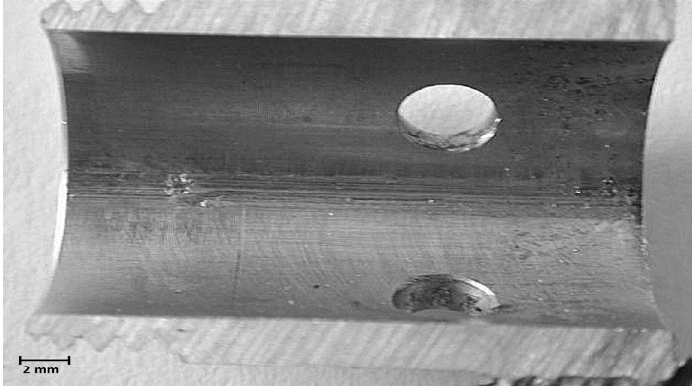
Figure 6: Sample 4, Nipple, Internal surface of the nipple with two of 4 holes and lubricant traces.